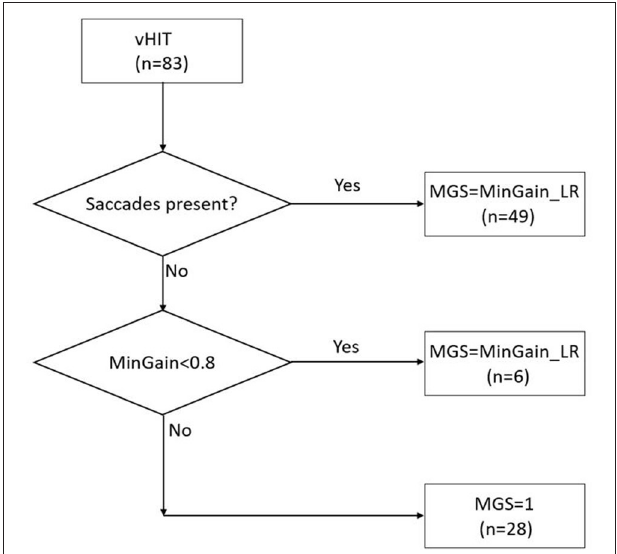
FIGURE 1 | The MGS (minimal gain & saccades) value is calculated based on the combination of the presence of saccades in the v-HIT and MinGain_LR, the lower of the two values of the v-HIT gain to the left and right. The numbers between brackets indicate the number of patients in the various categories in the present study